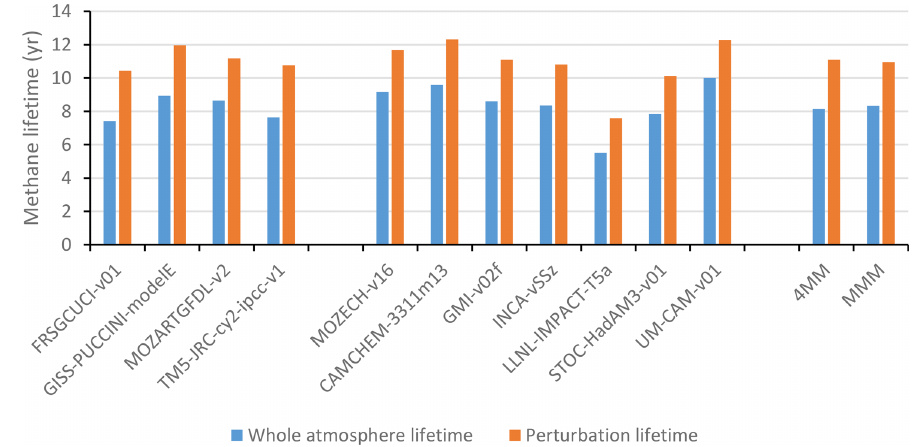
Figure 1. Whole-atmosphere and perturbation methane lifetimes (in years, blue) for the Hemispheric Transport of Air Pollutants (HTAP) models as well as the four-model mean (4MM) of the core models (four models on the left) and the multi-model mean (MMM). The perturbation lifetime was derived from 20% methane reduction experiments (orange; see Table S4).